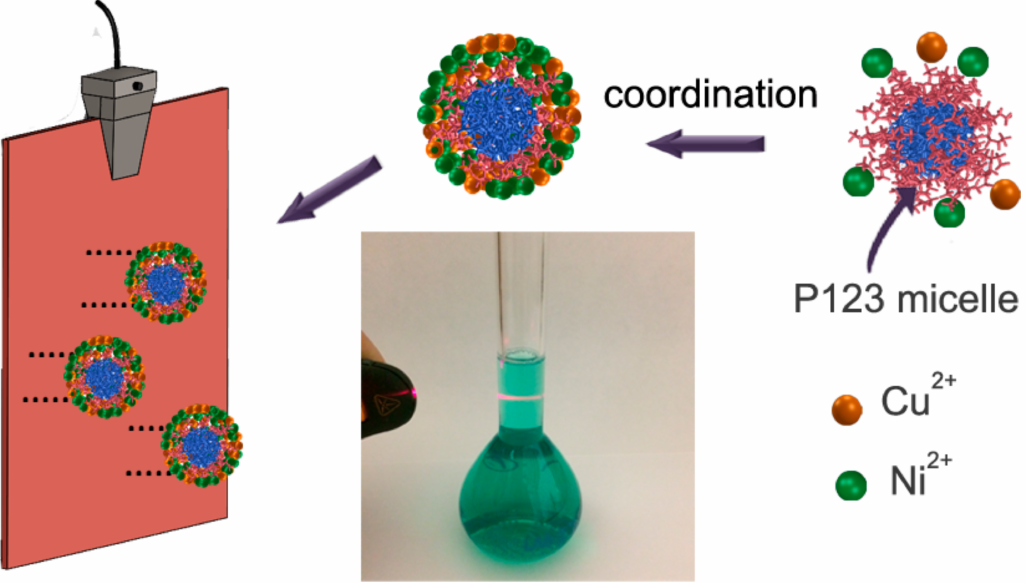
Figure 1. Schematic illustration of the preparation process. The photograph at the center of the sketch demonstrates the occurrence of the Tyndall